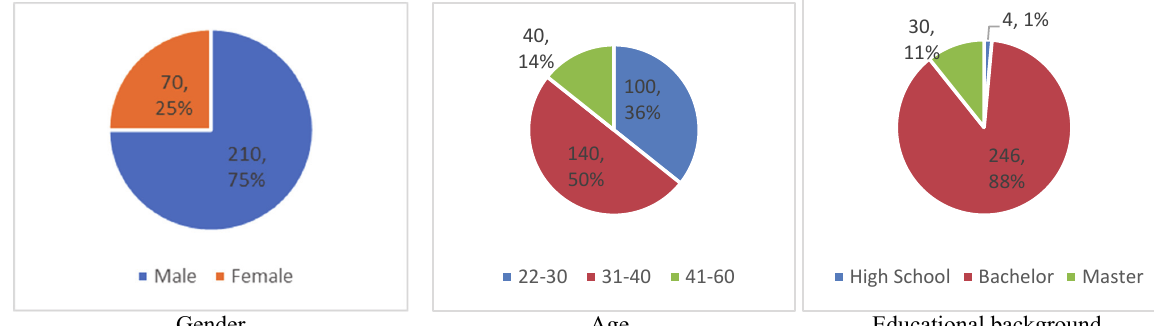
Fig. 2. Personal Characteristics of the participants